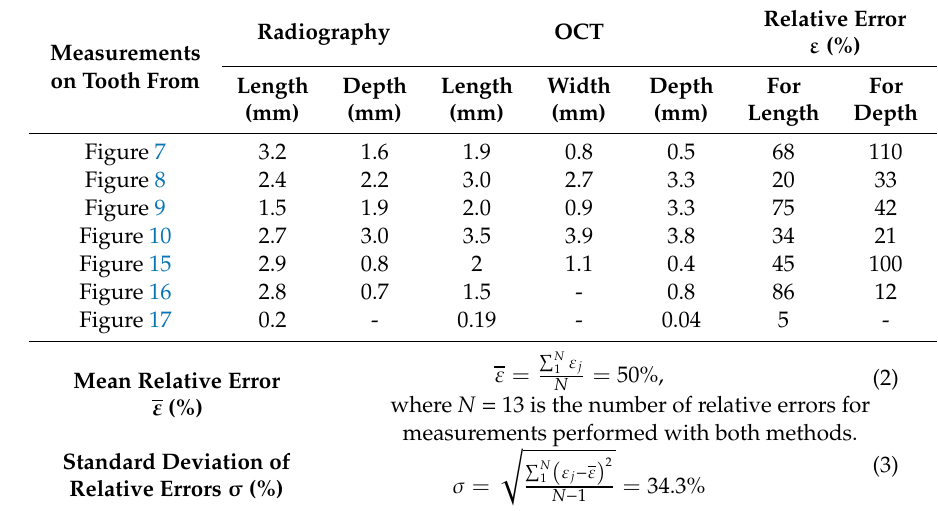
Table 1. Measurements performed on both radiography and OCT images obtained for the same